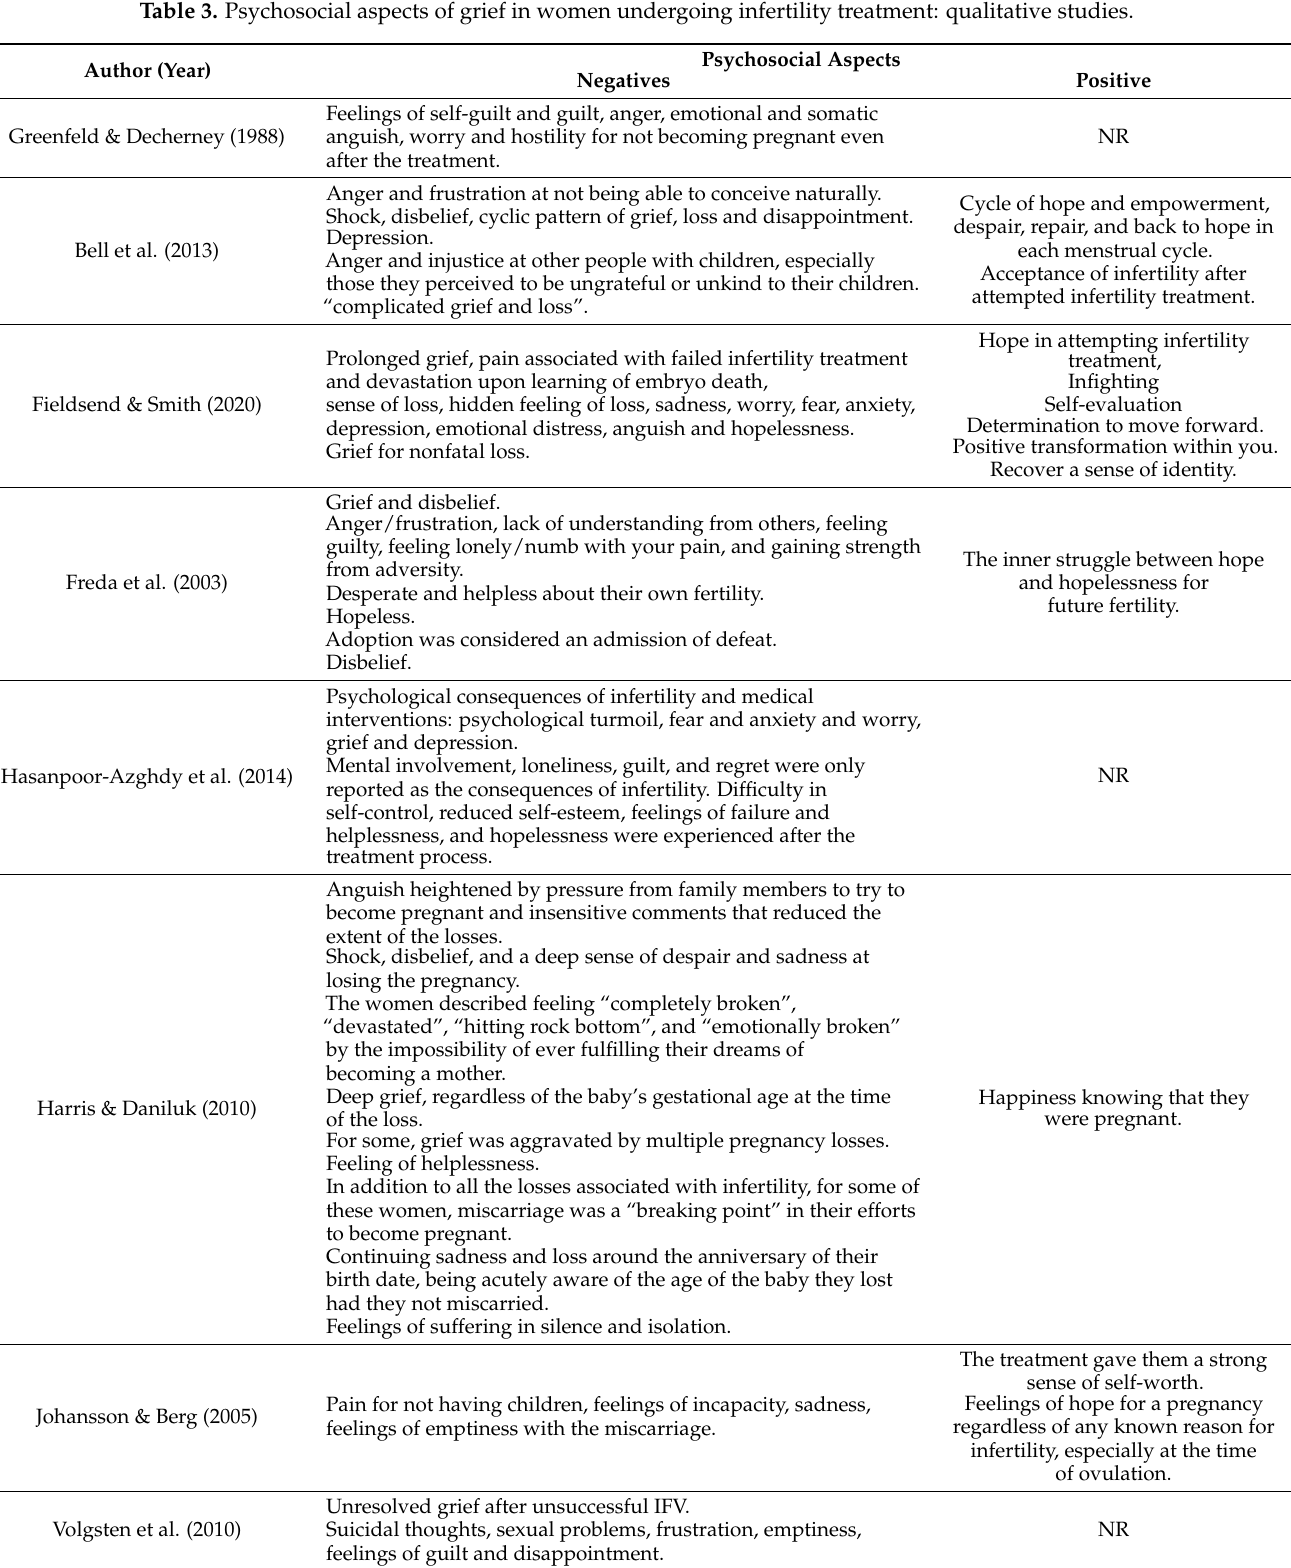
Table 3. Psychosocial aspects of grief in women undergoing infertility treatment: qualitative